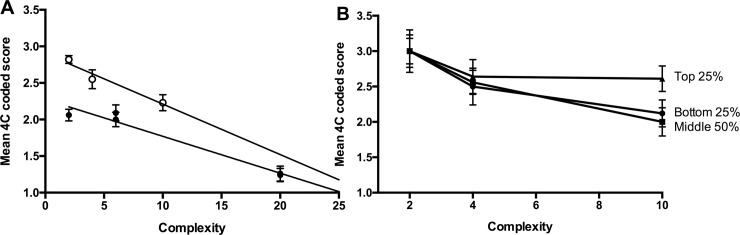
Writing syntax is negatively impacted by complexity but can be improved with writing support.(A) Writing syntax as a function of complexity measured by 4C scoring and reported as either unsupported (closed circles) or supported (open circles) by instructional intervention. Linear regression lines are shown (unsupported, R2 = 0.9644, supported R2 = 0.9471). (B) Students were stratified based on overall performance in the course. Statements from students within the group were averaged and reported. Error bars represent SEM.